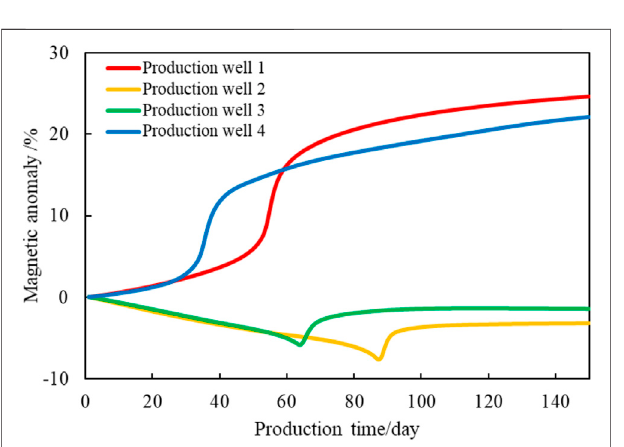
FIGURE 8 | Magnetic anomaly curves of production well in different reservoir regions.